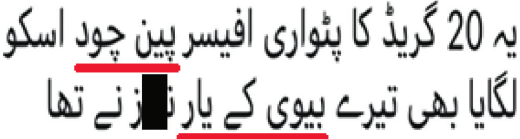
Figure 1: Tweet in Perso-Arabic-scripted Urdu with abusive